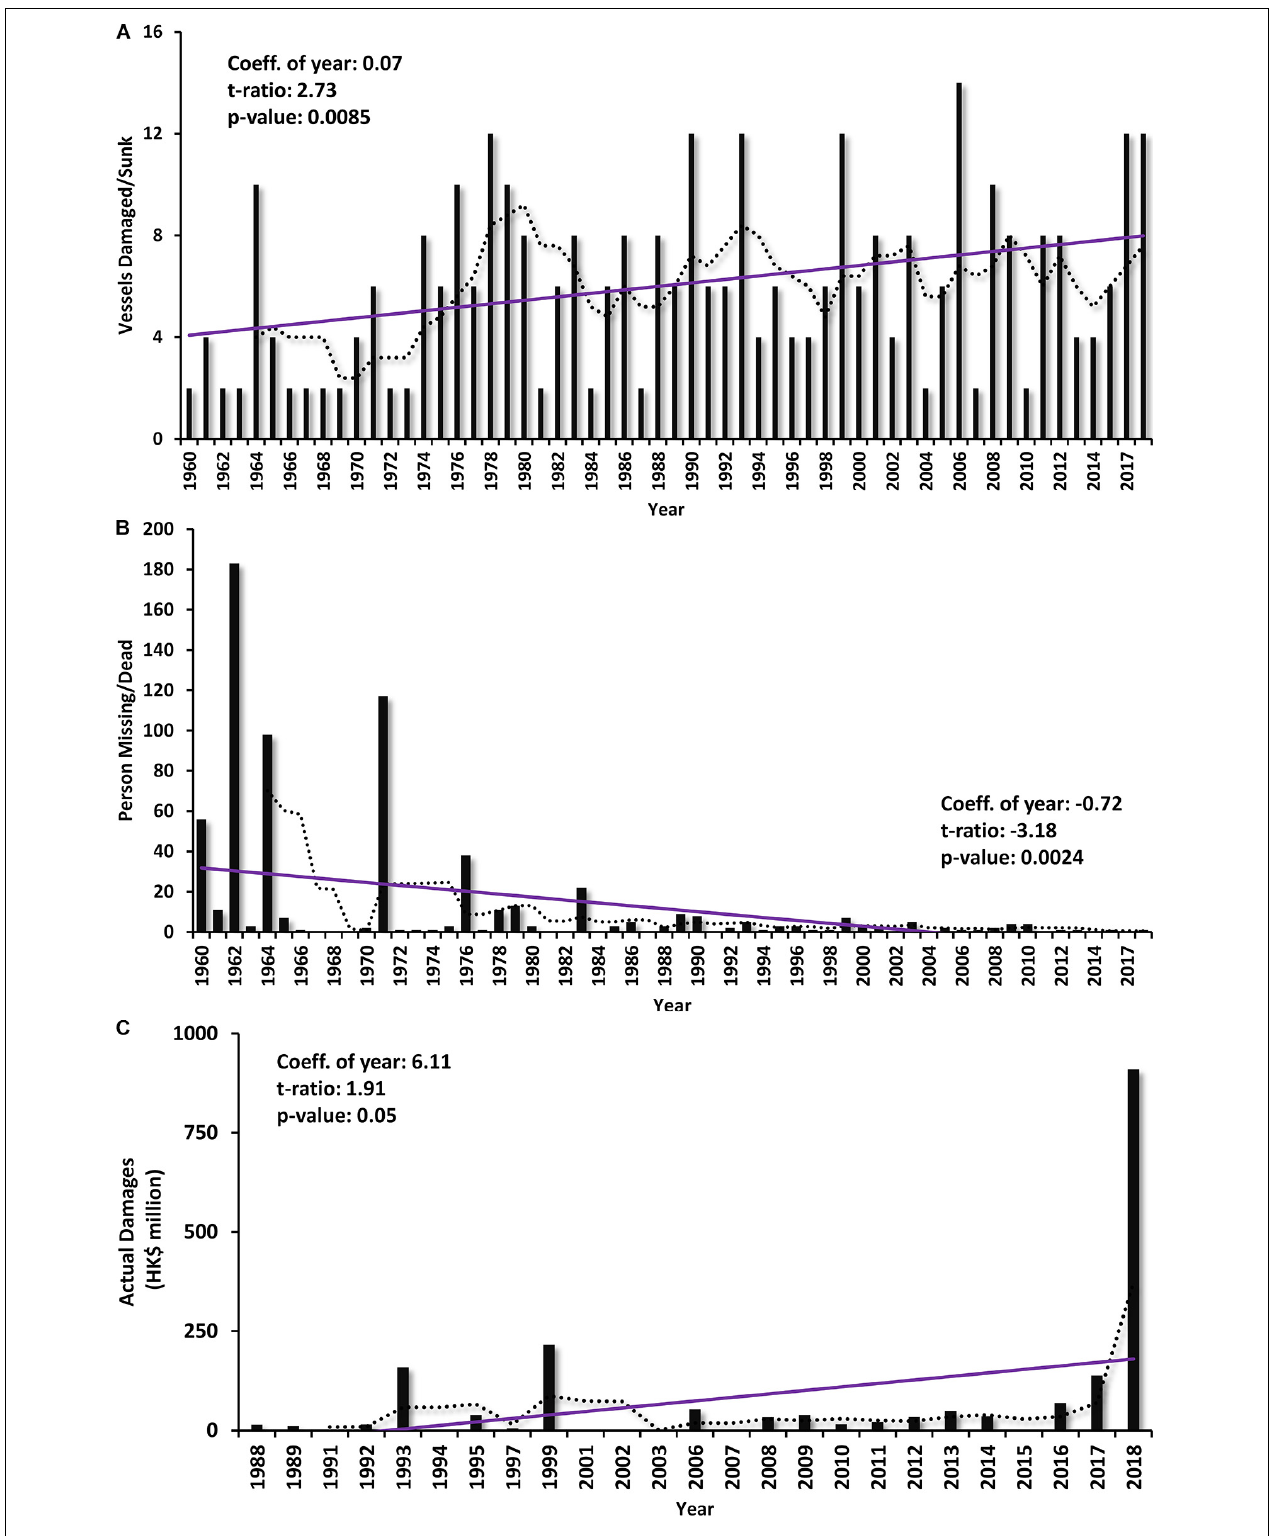
FIGURE 1 | Time series of TC-related impacts in Hong Kong. (A) number of vessels (sunk/damaged), (B) number of persons died/missing, and (C) actual observed TC-related damages (millions HK$). The solid purple lines show the long-term trend (correlation between the series and time). The dotted black line is the 5-year moving